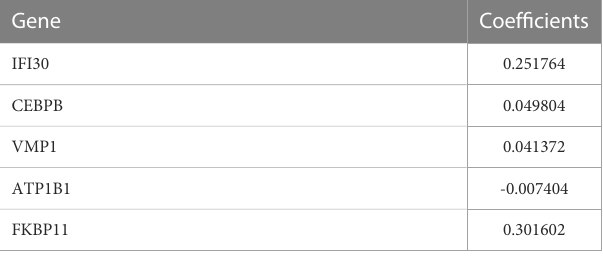
TABLE 1 Genes used for model building and their Coef fi